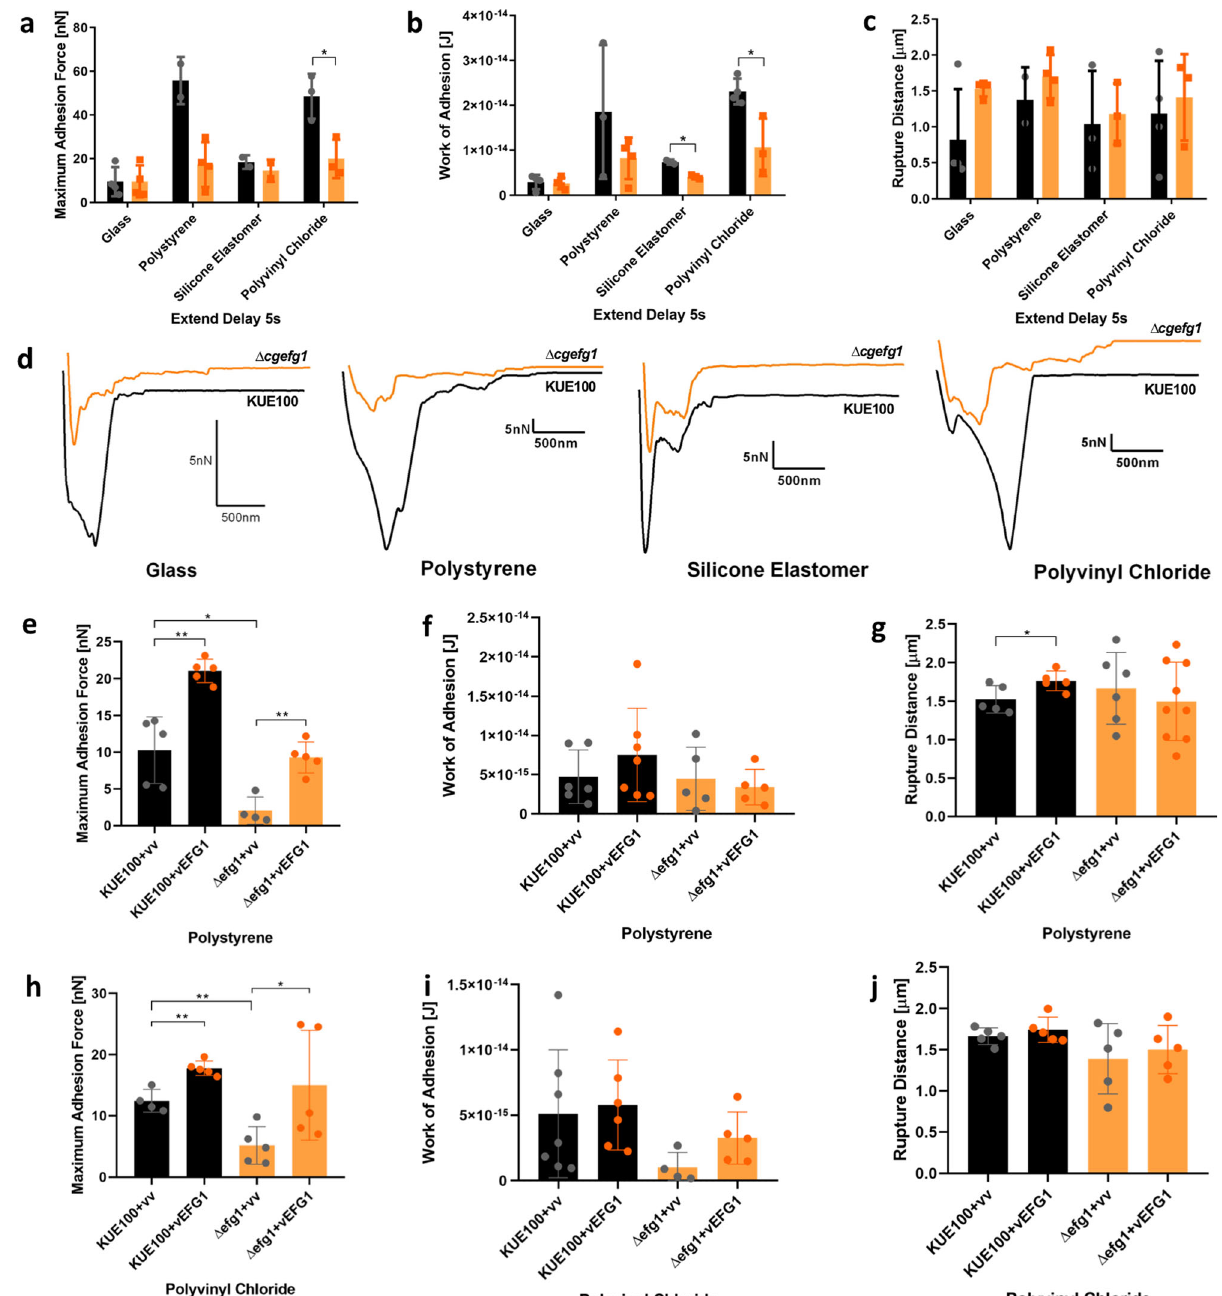
Fig. 7 CgEfg1 is necessary for the adhesion of C. glabrata to polystyrene, silicone elastomer, and polyvinyl chloride, with 5 s of contact time. The values obtained are the average levels of C. glabrata wild-type KUE100 strain (black) and deletion mutant Δ cgefg1 (orange) regarding a maximum adhesion force, b work of adhesion, and c rupture distance measured on each retraction curve. d Representative force – distance curves of the interaction with glass, polystyrene, silicone elastomer, and polyvinyl chloride, by C. glabrata wild-type KUE100 (black) and Δ cgefg1 deletion mutant single cells (orange). In addition, the average levels obtained for C. glabrata KUE100 and Δ cgefg1 strains harboring the pGREG576 cloning vector (vv), or the pGREG576_MT- I_ CgEFG1 (CgEFG1) plasmid regarding e , h maximum adhesion force, f , i work of adhesion, and g , j rupture distance measured on each retraction curve are also displayed. For every condition, at least four yeast cells, from at least three independent cell cultures, were immobilized on the cantilever for the interaction with each material. Twenty- fi ve force – distance curves were recorded per yeast cell. Error bars indicate SDs. * P < 0.05; ** P < 0.01, n ≥ 3, except for the wt level in a ( n =